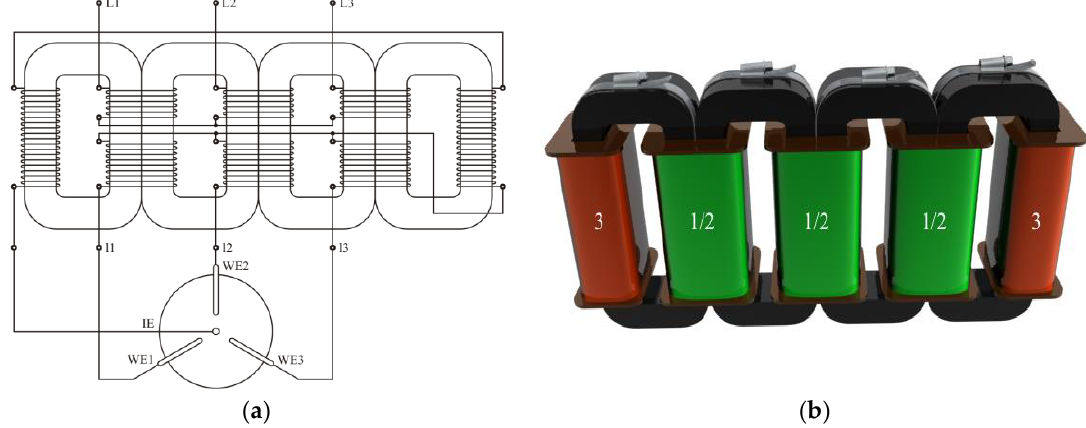
Figure 6. A 5-column transformer with external wound columns and a magnetic circuit made of wound cores; (a ) windings connection — external column windings connected in series; ( b ) arrangement of working and ignition coils on wound cores, 1/2 — concentrically wound primary and secondary windings, 3 — windings of external columns designed for supplying ignition systems of GAD plasma reactor [23,44].